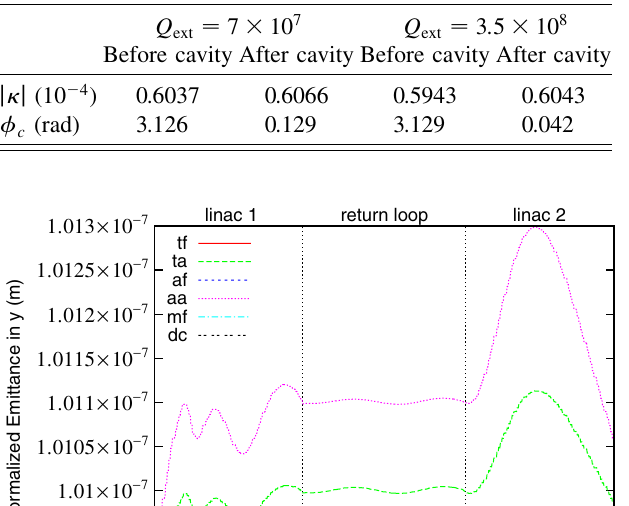
(cid:2) 7 (cid:9) 10 7 . ext